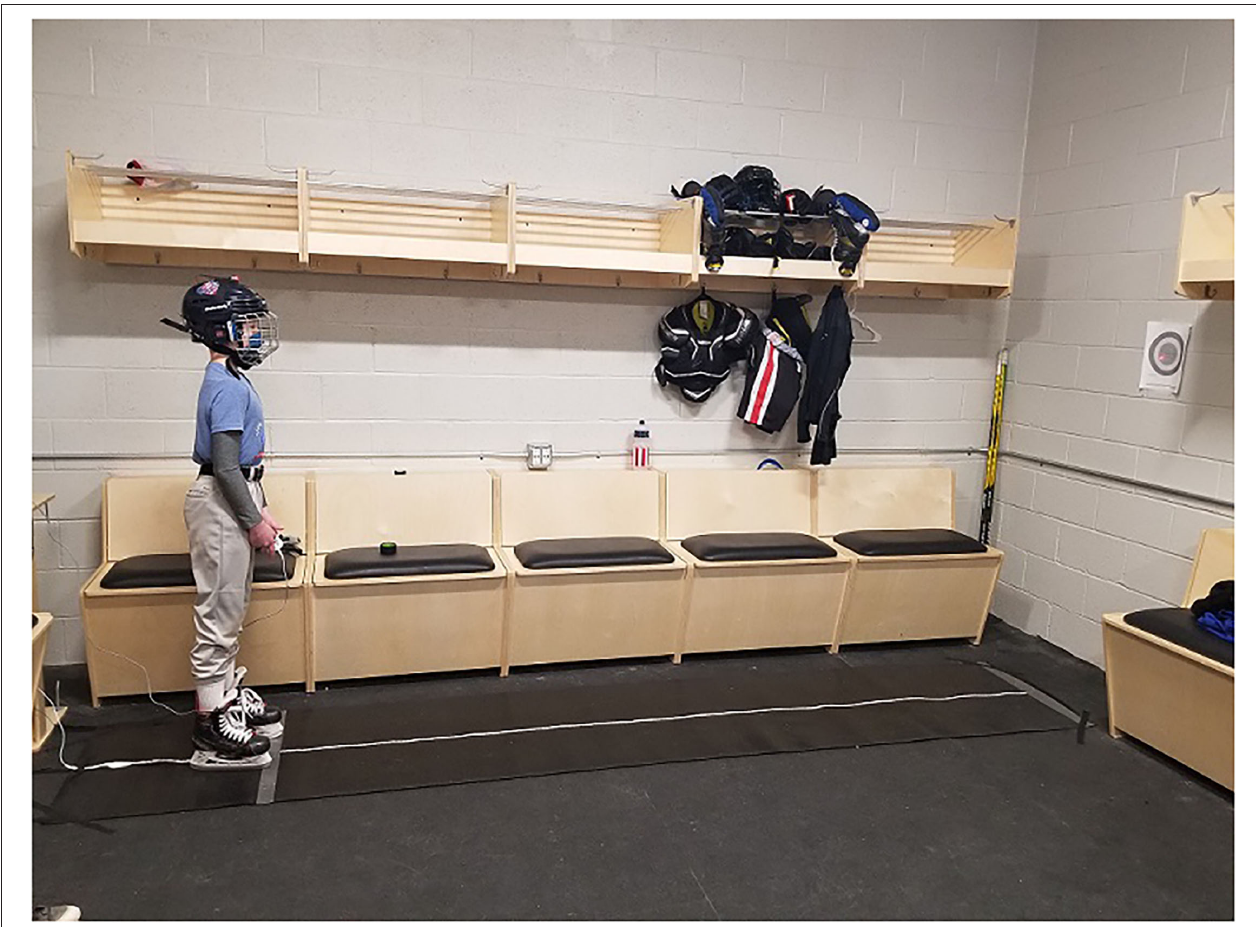
FIGURE 1 | An exemplar demonstrating the experimental set-up. Participants were instructed to keep the helmet mounted laser pointer in the center of the bulls-eye (Radius 9.1cm) taped to the wall at eye height 12 feet away. Subjects stood with a comfortable stance straddling the LED strip in their skates holding the Xbox controller so that it was not visible while looking straight